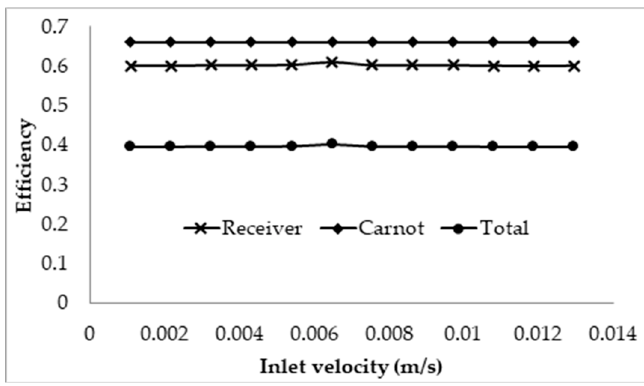
Figure 8. Effect of inlet velocity on the efficiency of the receiver at a fixed peak temperature. Figure 8. E ff ect of inlet velocity on the e ffi ciency of the receiver at a fixed peak temperature.